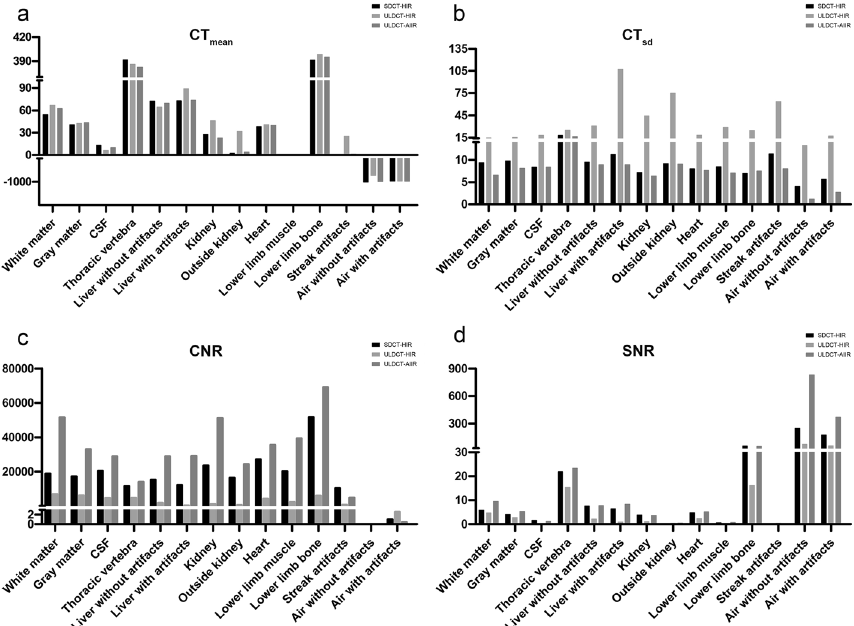
Fig. 1 Box plot of objective measurements on phantom among the SDCT-HIR, ULDCT-HIR and ULDCT-AIIR. ( a – d ): The CT mean , CTsd, CNR and SNR of the SDCT-HIR, ULDCT-HIR and ULDCT-AIIR